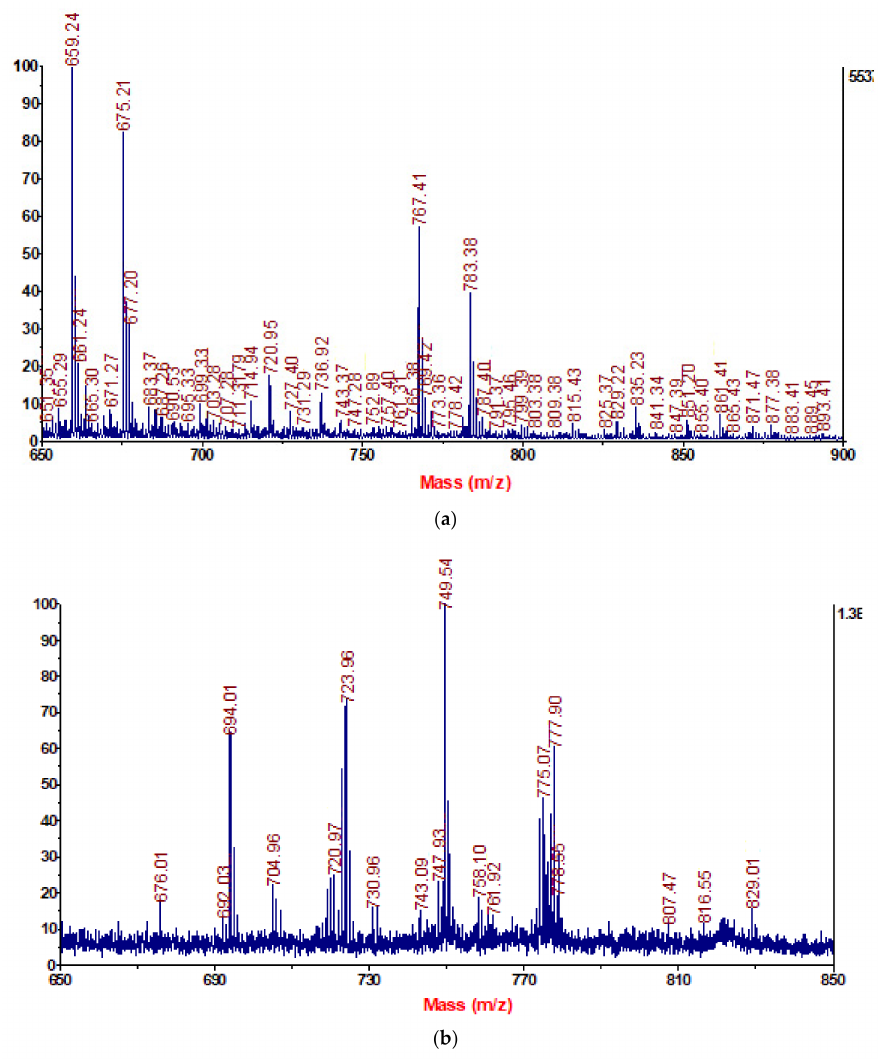
Figure 2. A MALDI-TOF mass spectrum in the positive reflector ion mode (mass range of 600–900 Da) of ( a ) raw lipid extract from D. tertiolecta and ( b ) phospholipid sample after µ SPE-TiO 2